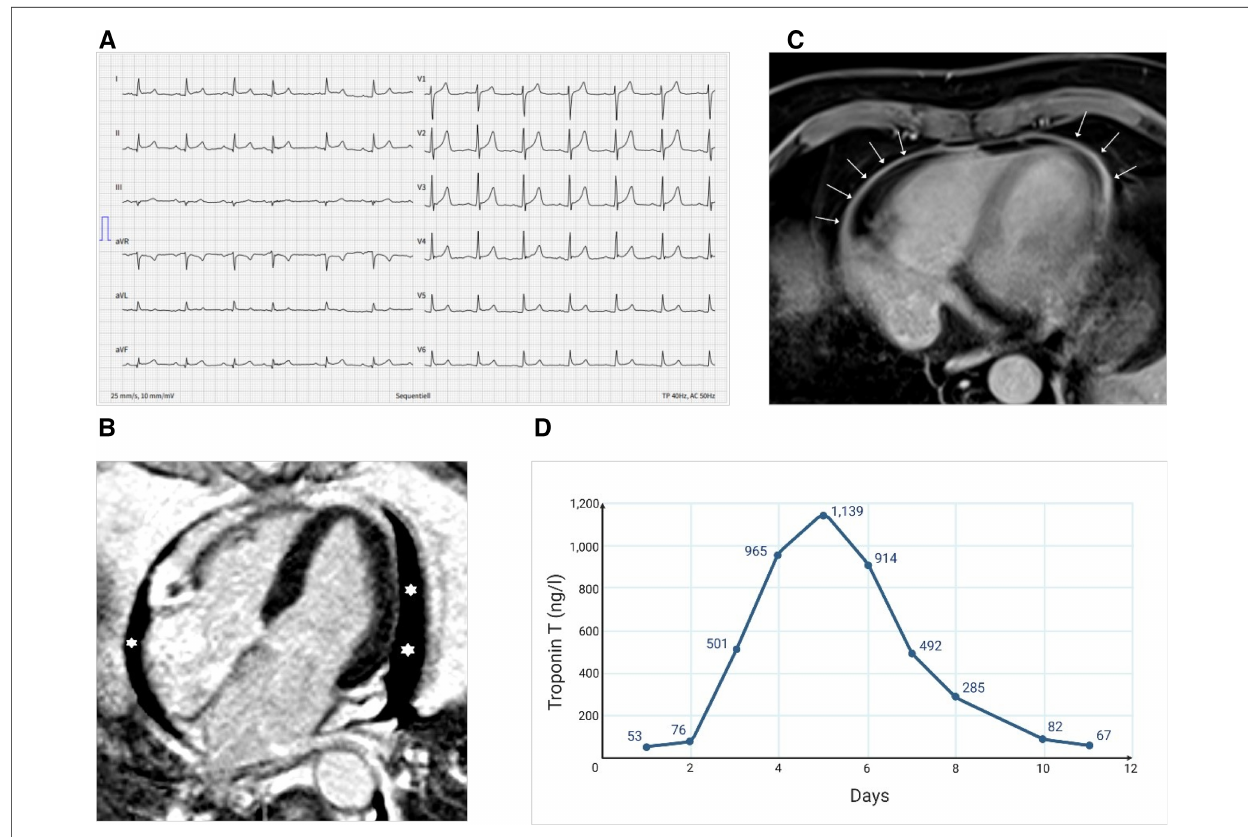
FIGURE 1 Electrocardiographic and imaging fi ndings at admission and course of high-sensitive troponin T. ( A ) ECG showing diffuse concave ST-elevation (II, aVF, V3-6) and PQ-depression (II, aVF). ( B ) MRI showing pericardial effusion (asterisks) in the four-chamber view (late enhancement PSIR). ( C ) MRI showing pericardial enhancement (arrows) (axial T1 DIXON Water only, which is a fat-saturated, non-ECG-triggered). ( D ) Longitudinal evolution of the high- sensitive troponin T levels during the hospitalization (MRI done on day 3; i.e., troponin 501